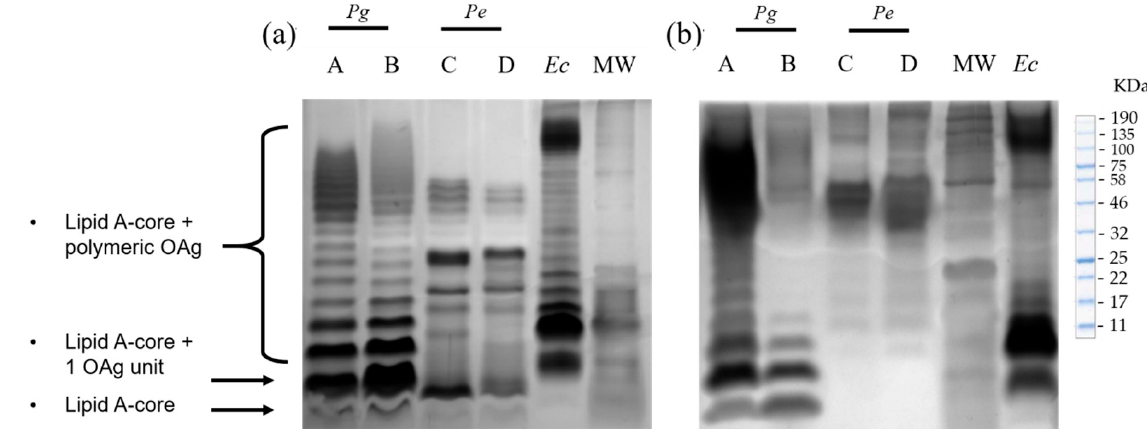
Figure 1. Representative silver-stained Tris-Tricine gels of P. gingivalis and P. endodontalis LPS; ( a ) Bacterial lysates. ( b ) Purified LPS. A: P. gingivalis reference strain ATCC 33277; B: P. gingivalis from clinical isolate AC1 Pg ; C: P. endodontalis reference strain ATCC 35406; D: P. endodontalis from clinical isolate AC2 Pe ; Ec : commercial E. coli LPS (BioLabs, Ipswich, MA, USA). MW: Molecular Weight Ladder.